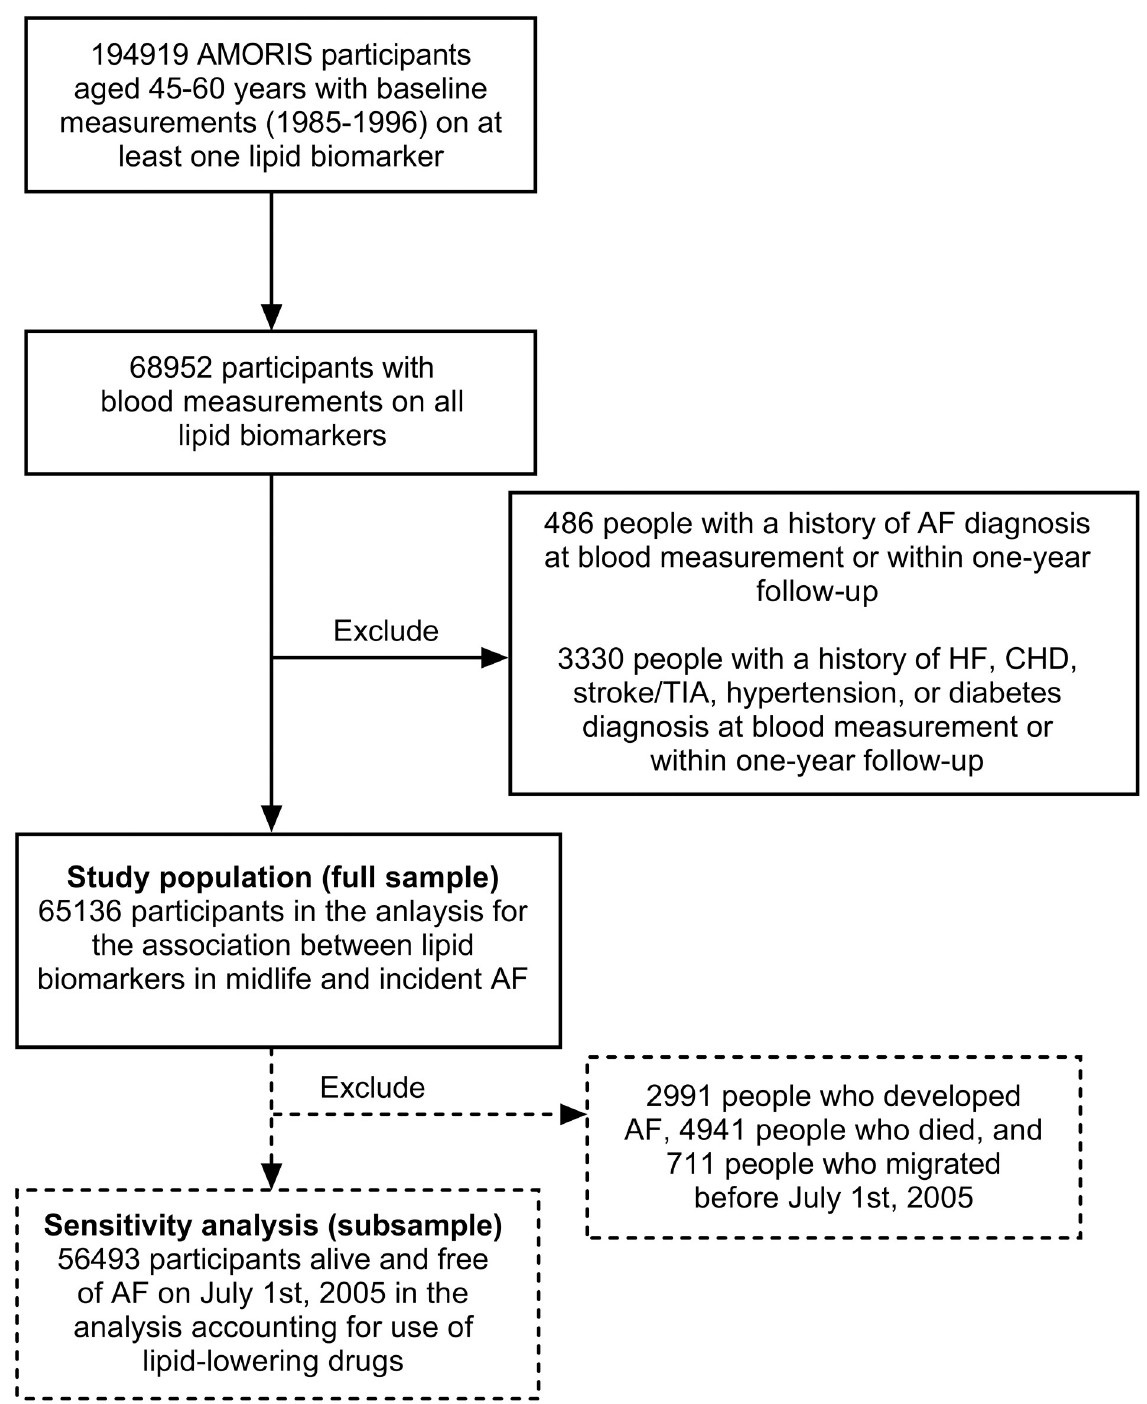
Fig 1. Flow chart of the study population in the AMORIS cohort. AF, atrial fibrillation; AMORIS, Apolipoprotein-Related Mortality Risk; CHD, coronary heart disease; HF, heart failure; TIA, transient ischemic attack.